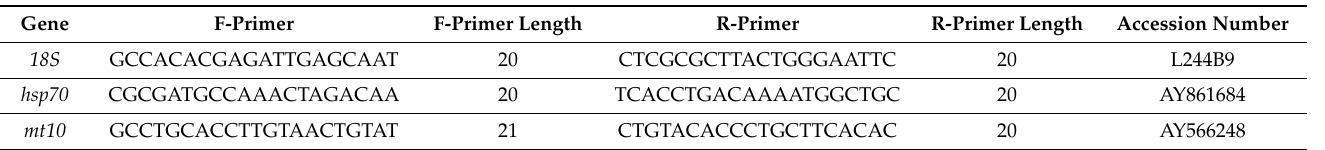
Table 1. List of forward and reverse primers used for amplification of each gene analyzed and for the reference housekeeping 18S